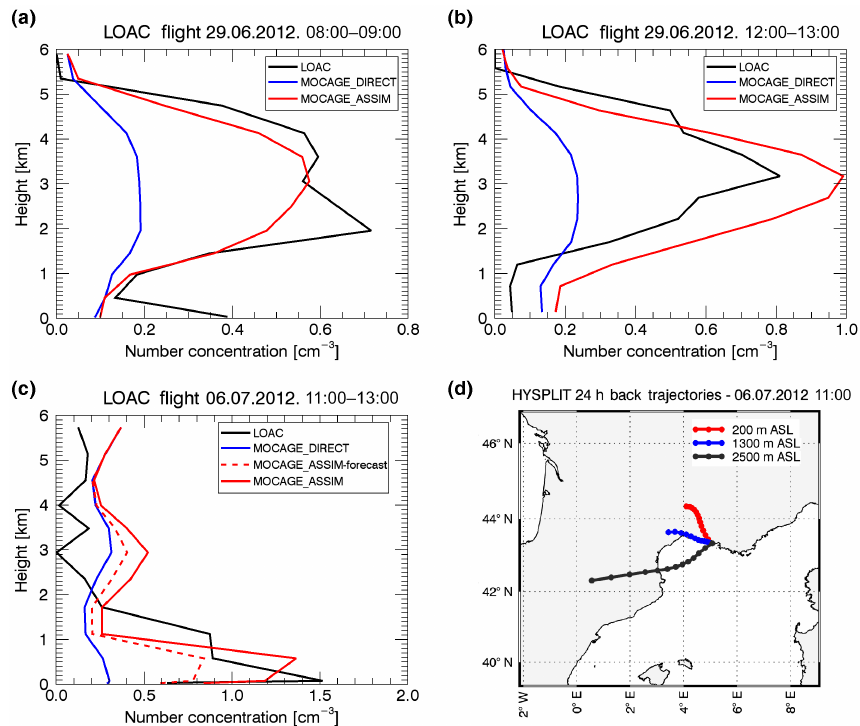
Figure 9. Aerosol number concentration (cm − 3 ) from the LOAC instrument on board the meteorological sounding balloons. The presented flights are performed: in the morning of 29 June 2012 (a) , at noon of 29 June 2012 (b) and on 6 July 2012 (c) . LOAC measurements (black line) are compared with the direct model run (blue line) and the assimilation model run (red line). For the third flight, we also present the 1h forecast (first guess) started from the assimilated conditions of 1h before (dashed red line). The aerosols are considered in the size range from 2.5 to 100µm. In addition, for the third flight, we present the 12h back trajectories obtained by the National Oceanic and Atmospheric Administration’s HYSPLIT model (d) . They show directions of the origin of air parcels at the three different starting heights, 200, 1300 and 2500m above sea level, for the starting location of 42 . 33 ◦ N, 5 . 08 ◦ E and the starting time of 6 July 2012 at